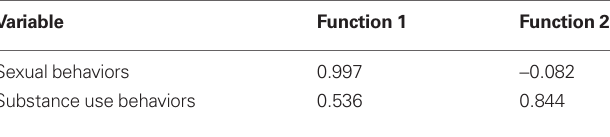
Table 4 | Structure coefficients for discriminant analysis comparing cluster means on number of risky sexual and substance use